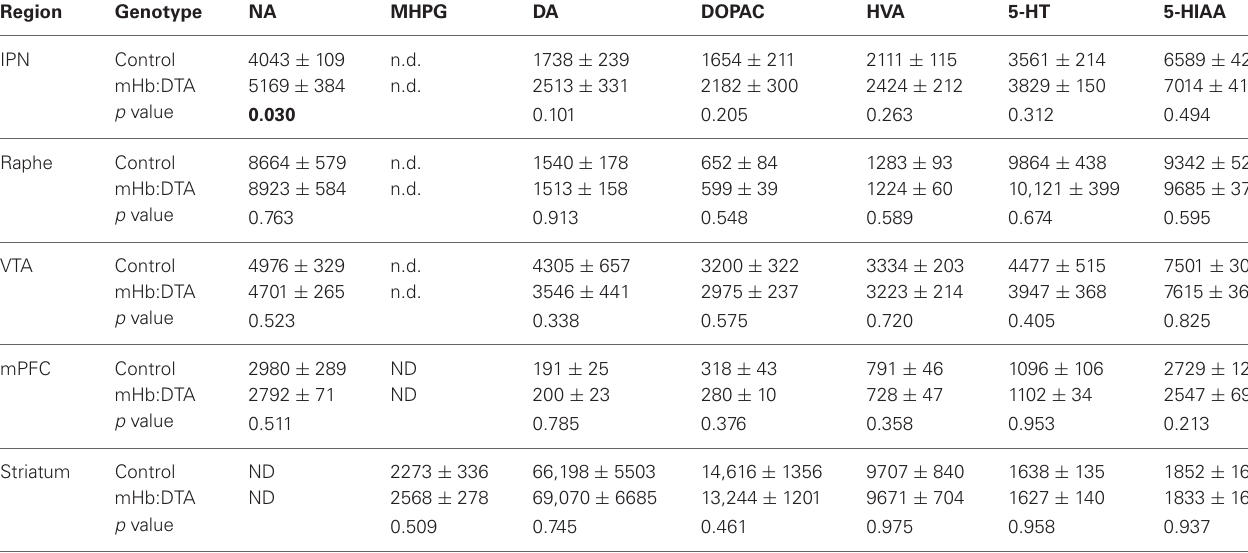
Table 1 | Levels of monoamines and metabolites in selected brain regions.